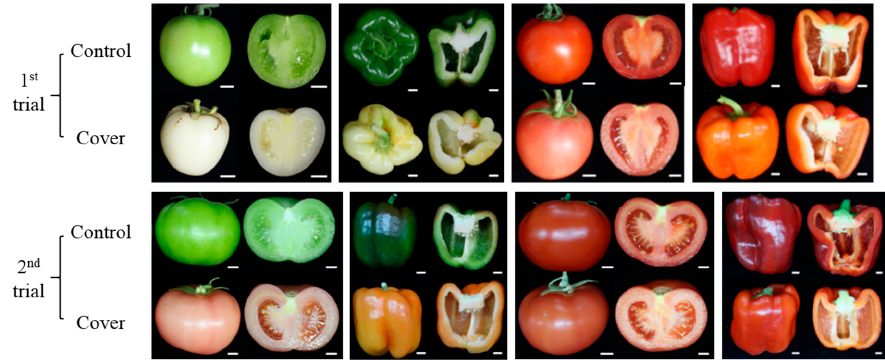
Figure 1. Tomato and pepper fruits under normal and cover conditions. Immature tomato and pepper fruit were covered with high-density polyethylene bags for 50–80 days and harvested on October 2017 (first trial) and March 2018 (second trial). Bar = 1